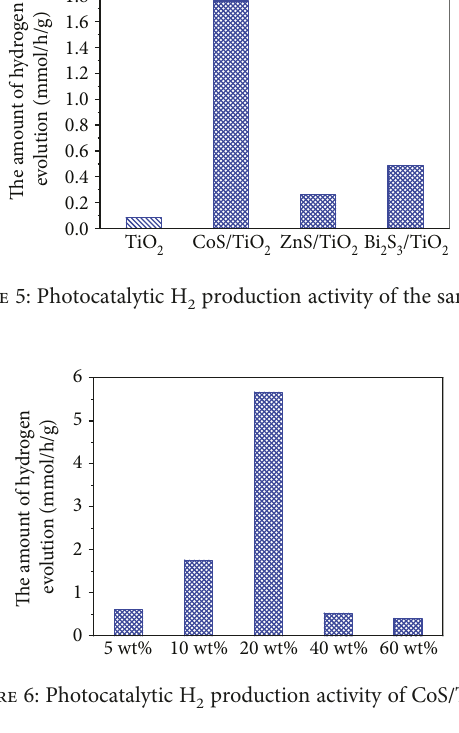
production activity of CoS/TiO 2